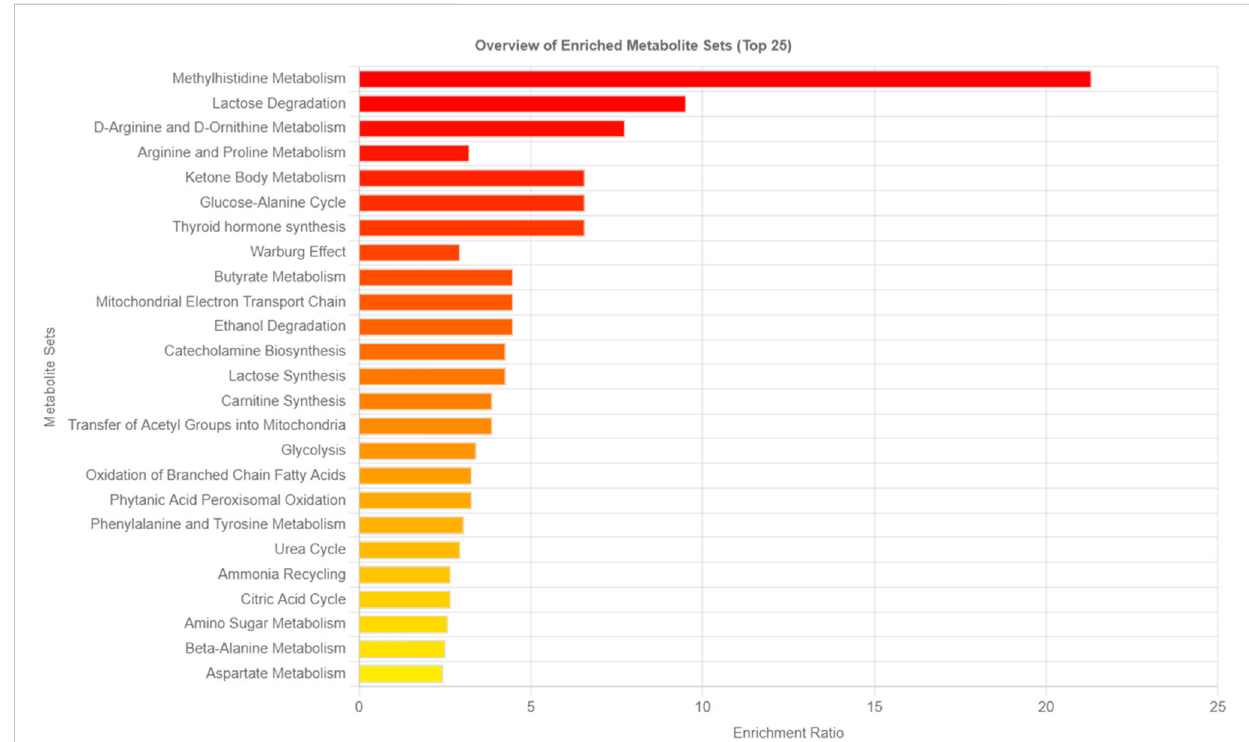
FIGURE 5 Metabolic pathways associated with the top 15 identi fi ed potential metabo-lites. The horizontal bars show a summary of metabolic pathways that werestronglyaffectedinthe Trichinellazimbabwensis infectedgroupcomparedtothecontrol.Colorintensity(whitetored)re fl ectsincreasingstatistical signi fi cance.